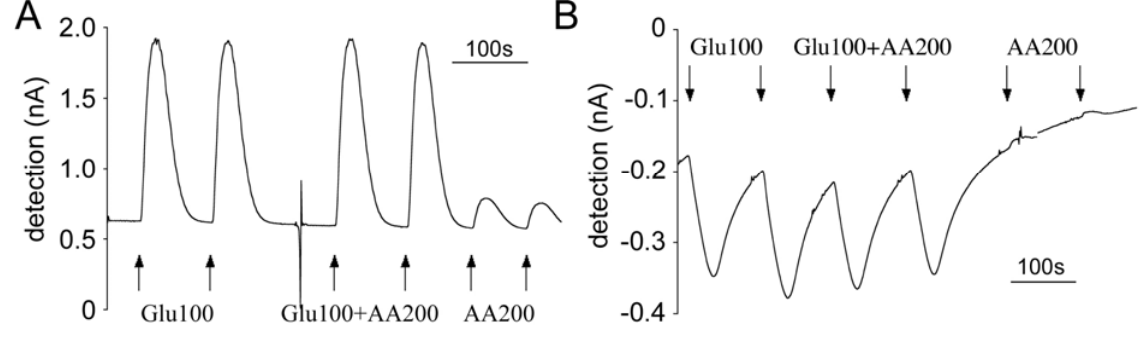
Figure 6. Typical raw amperometric calibration profile of the first and second generations of glutamate microsensors with FIA system at flow rate of 1 mL/min. Interfering compounds and analyte were administered in duplicate as 30 second bolus injections. (A) Calibration with the first generation sensor at +700 mV. (B) Calibration with the second generation sensor at –150 mV.